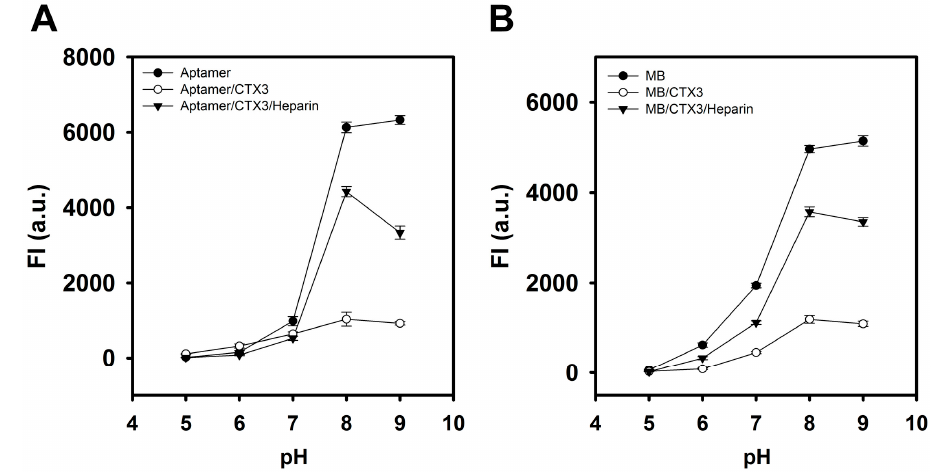
Figure 7. Effect of pH on the fluorescence recovery of ( A ) CTX3-aptamer and ( B ) CTX3-MB sensors with the addition of heparin. ( A ) the used aptamer, CTX3, and heparin concentrations were 20 nM, 300 nM, and 1.8 µ g/mL, respectively; ( B ) the used MB, CTX3, and heparin concentration were 10 nM, 200 nM, and 1.8 µ g/mL, respectively.